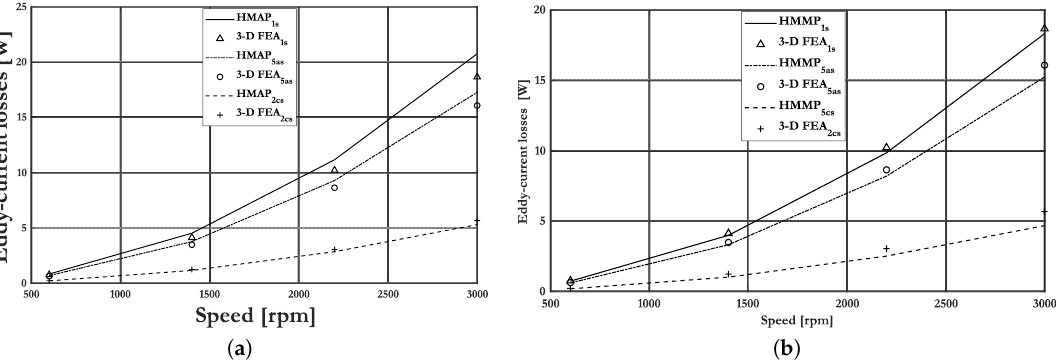
Figure 22. Eddy-current losses comparison with 3-D FEA: ( a ) all paths, and ( b ) middle path of PMs.